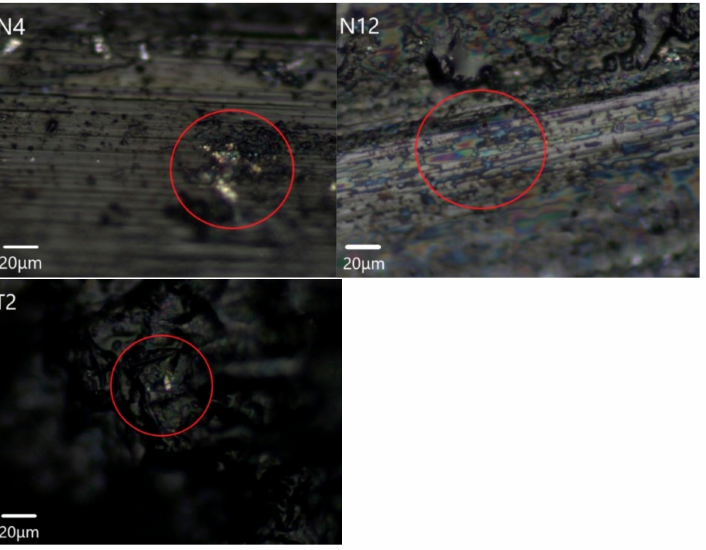
Figure 10. Location and morphology of zoisite inclusions in tanzanite samples N4, N12 and T2. To determine that zoisite inclusions in the iridescent effect were not tanzanite itself,